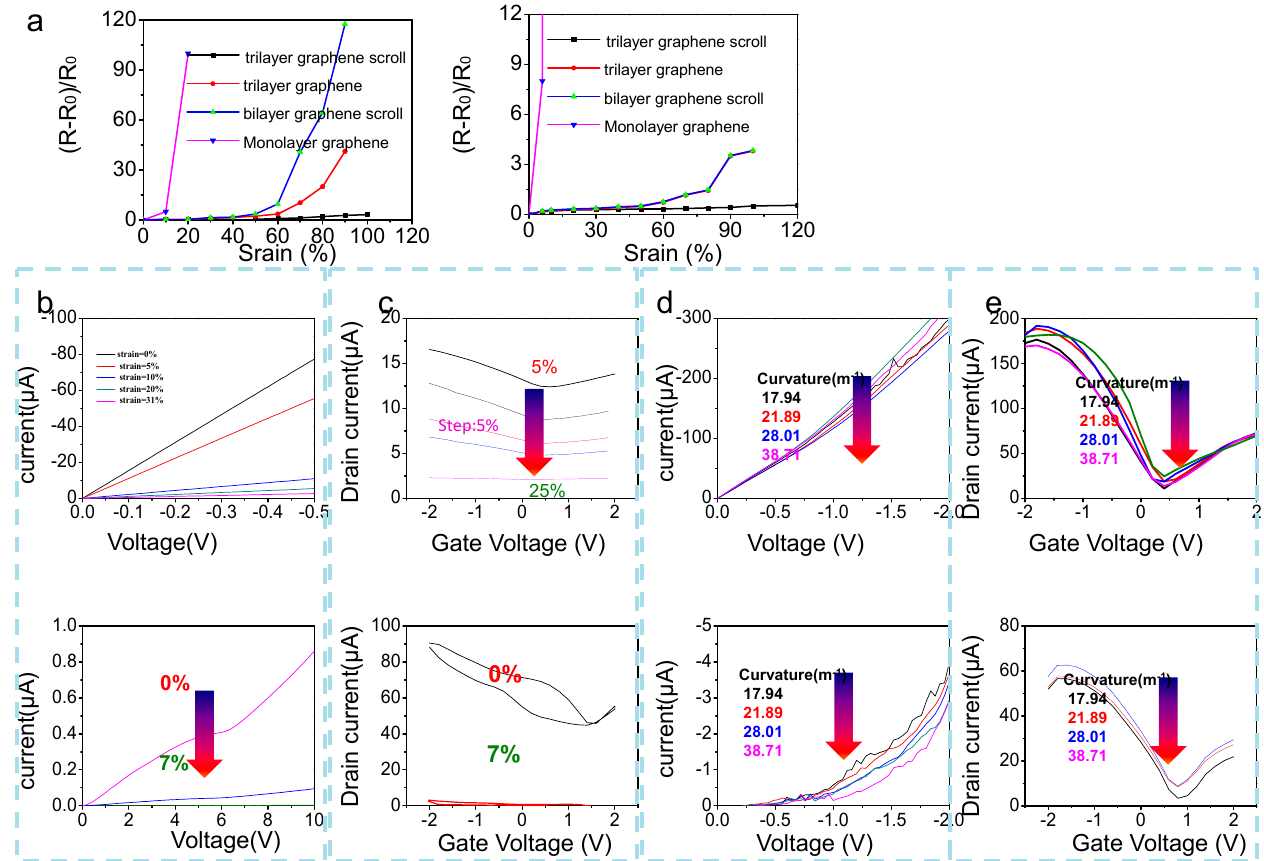
Figure 2. Electrical properties of GFET/GSFET under deformation. ( a ) Normalized relative resistance change of monolayer graphene, bilayer graphene scrolls, trilayer graphene, and trilayer graphene scrolls as a function of perpendicular ( left panel) and parallel ( right panel) stretch and strain to the direction of current flow. ( b ) I-V curve of trilayer graphene scrolls ( top panel) and monolayer graphene ( bottom panel) at varied strain deformations. ( c ) Transfer curve of trilayer graphene scrolls ( top panel) and monolayer graphene ( bottom panel) at varied strain deformations (at given V D of 0.1 V). ( d ) I–V curve of trilayer graphene scrolls ( top panel) and monolayer graphene ( bottom panel) at varied bending deformations. ( e ) Transfer curve of trilayer graphene scrolls ( top panel) and monolayer graphene ( bottom panel) at varied bending